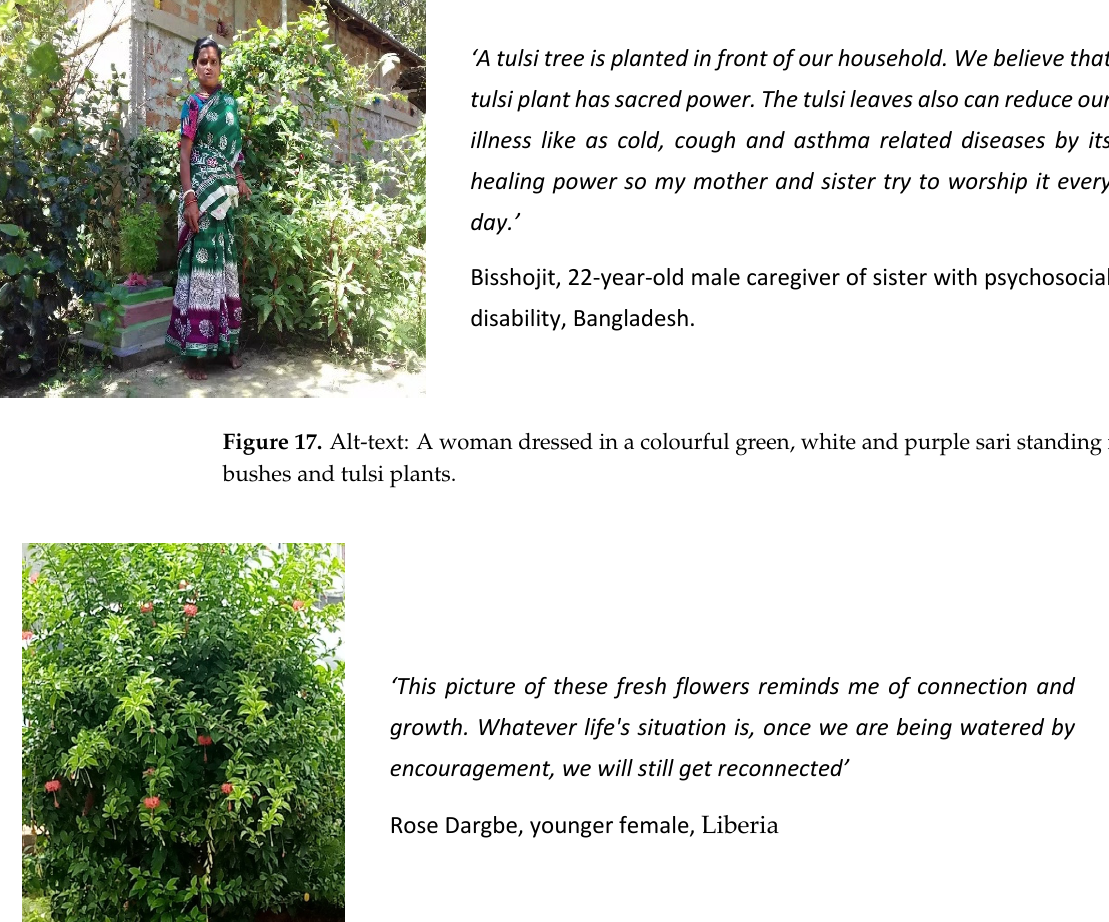
Figure 16. Alt-text: A large crowd of people sitting outdoors for Eid prayers.